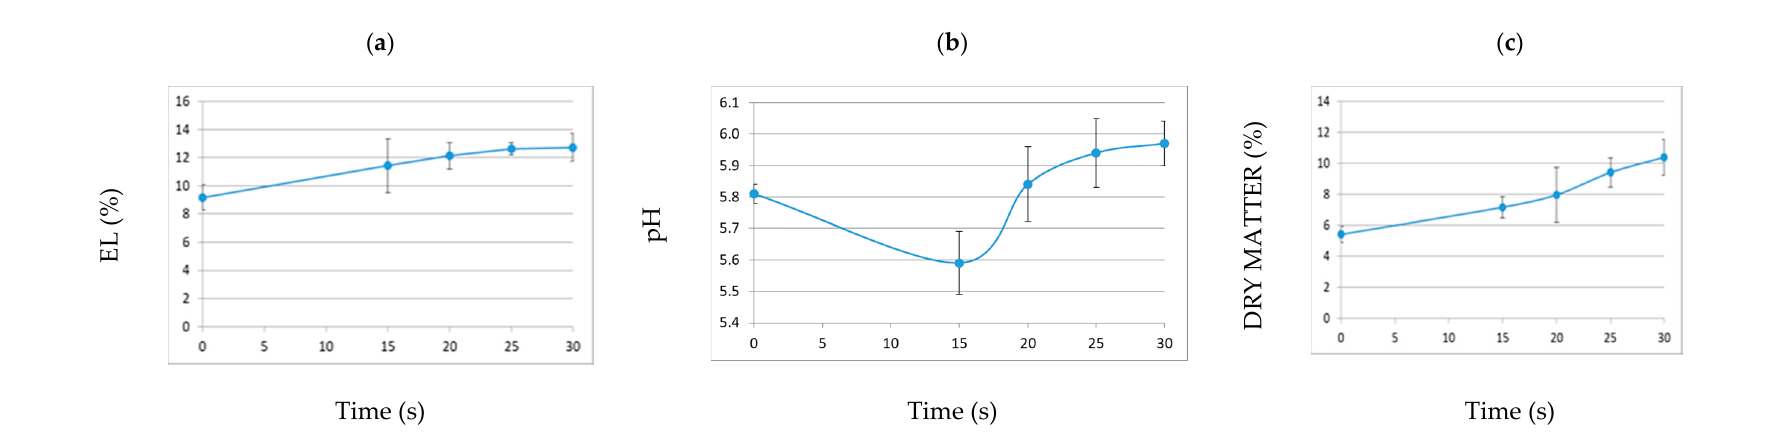
Figure 4. Plasma-induced changes in physicochemical parameters (electrolyte leakage (EL) ( a ), pH ( b ), and dry matter content ( c )) of lettuce leaves as a function of the plasma treatment time (mean values ± standard error). There were no significant differences between time points, according to the ANOVA followed by Sidak post-hoc test ( p < 0.05; n = 3).